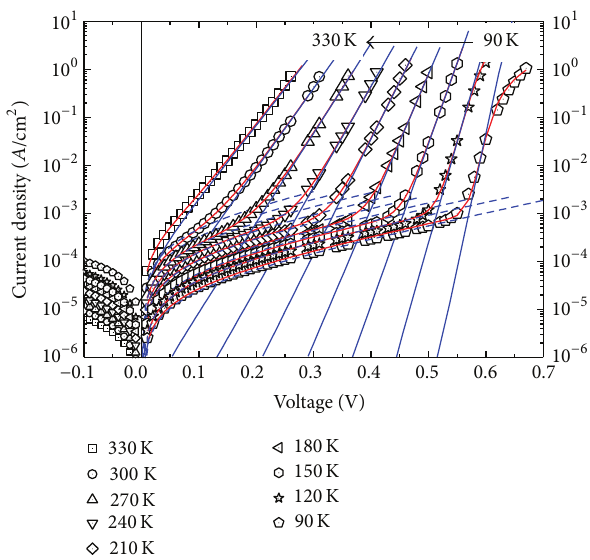
Figure 6: Forward and reverse dark IV characteristics of a Ge “subcell” at different temperatures (from 90 to 330 K). Symbols are the experimental data: red line: the calculations by the two- exponential model, blue line: the diffusion components ( 𝐴 𝑑 = 1 ), and blue separated line: the tunneling components ( 𝐸 𝑡 = 0.17